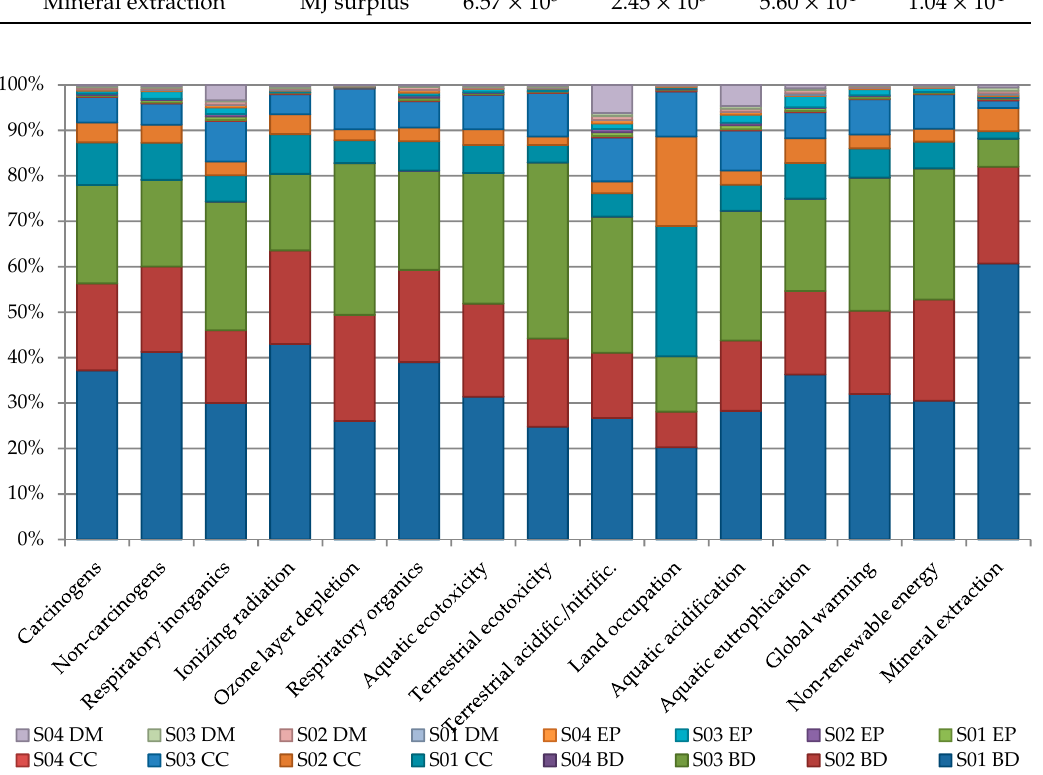
Figure 3. The share of hotspots in impact categories for investigated biogas plants (BD, biomass delivery; CC, crop cultivation; EP, energy production; DM, digestate management), based on SimaPro calculations.